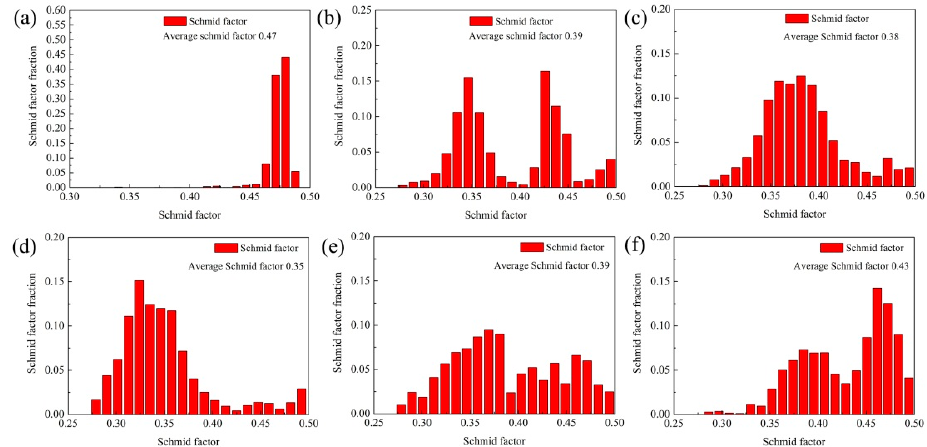
able to significantly alter the misorientation distribution of the Ti 2 AlNb alloy. The average Schmid factors of the various slip systems is summarized in Table 3.